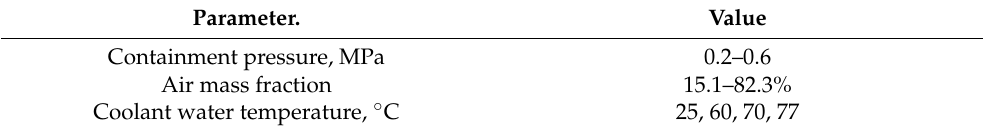
Table 1. Specific experimental